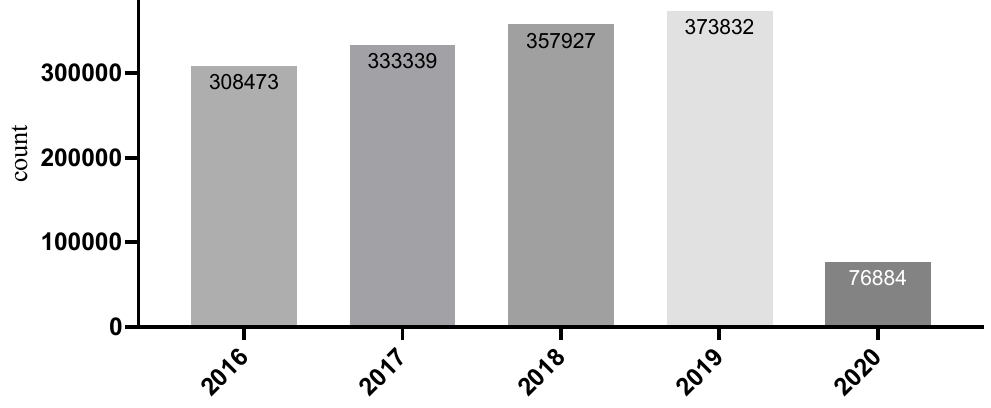
Figure A1. The number of visits analyzed versus the year of measurement.